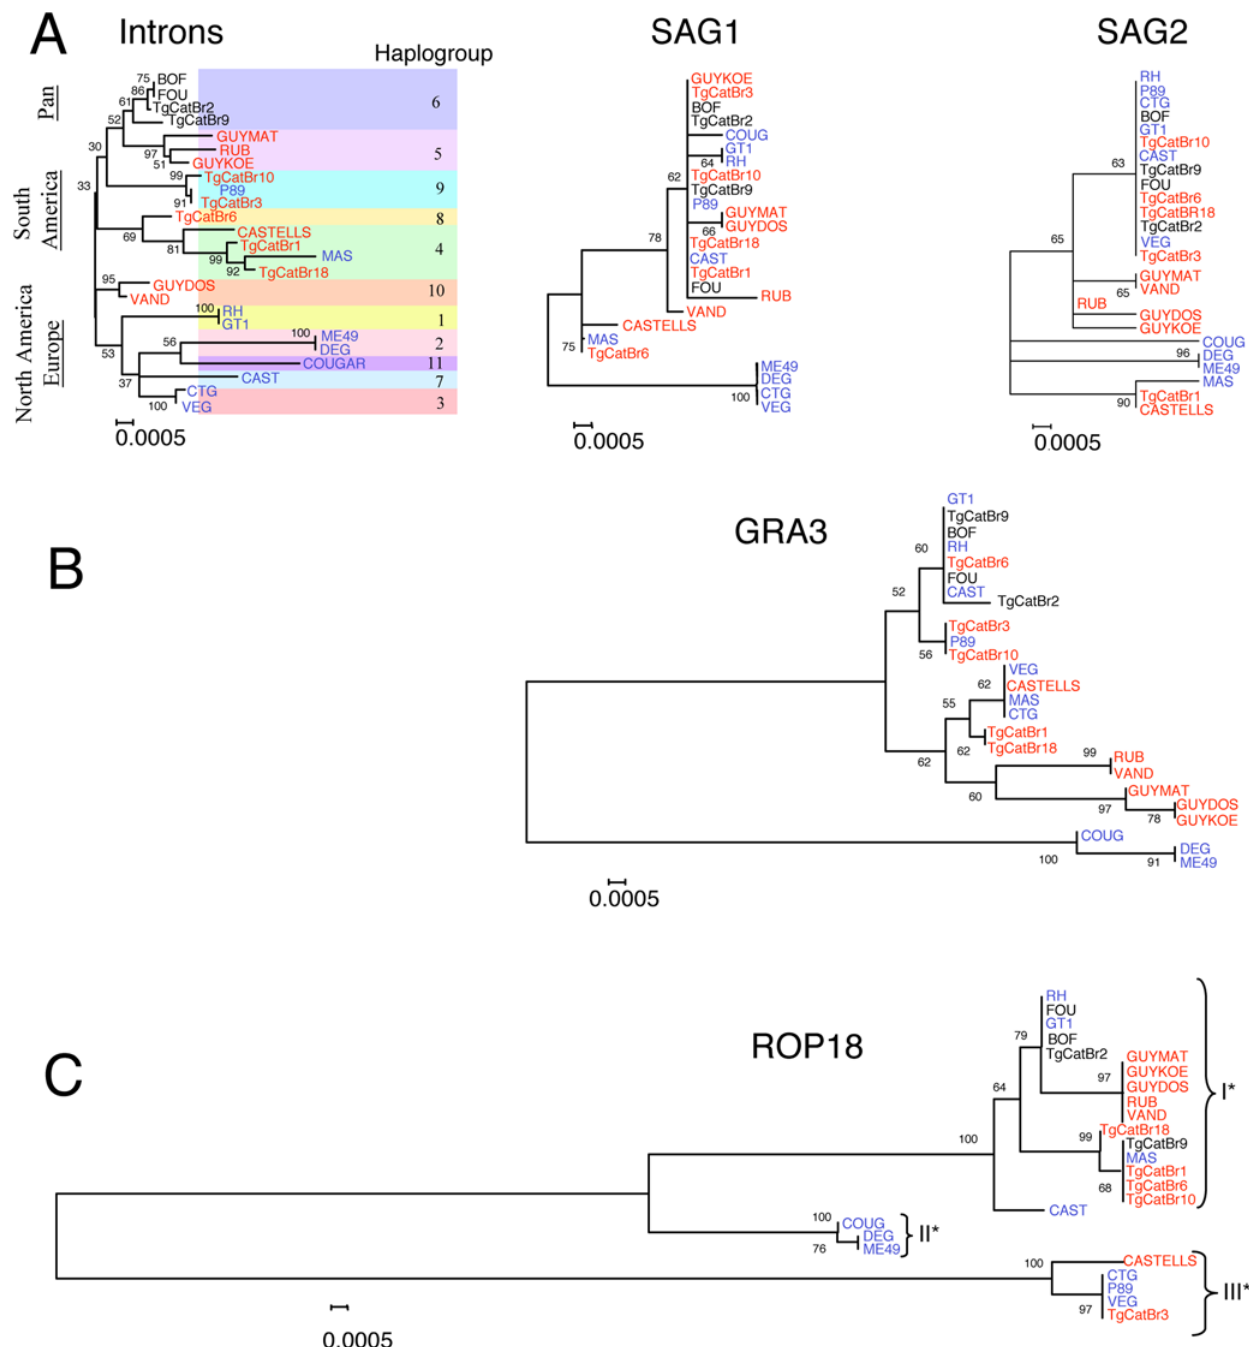
Figure 2. Phylogenetic analysis reveals ROP18 is highly divergent relative to other loci. A) Combined analysis of 8 introns from 25 strains defines 11 major haplogroups of T. gondii that show strong geographic segregation. Separate gene trees for the antigens SAG1 and SAG2 show overall lower diversity of alleles but approximate the same level of divergence seen in the combined intron tree. B) The highly polymorphic gene GRA3 shows deeper branching of multiple major alleles, which are not associated with geographic region or virulence. C) In contrast the much higher genetic divergence of ROP18 is partitioned into only three major alleles (denoted by I*, II*, and III*). Neighbor-joining analysis with 1000 bootstraps (values shown at major nodes). Color-coded by continent of origin: North America-Europe (blue), South America (red), widespread (denoted as Pan, black). antigens (i.e. SAG1 , SAG2 ), and GRA3 . This comparison was based understand whether alleles of ROP18 have experienced atypical not only on the clonal lineages, but on all strains that were evolutionary pressures, we classified the extent of synonymous (S) grouped by their ROP18 alleles into major types as defined in vs. nonsynonymous (NS) mutations at this and several other genes, Figure 2B. Both S and NS substitutions were much more frequent including housekeeping genes (i.e. actin and b -tubulin ), the surface